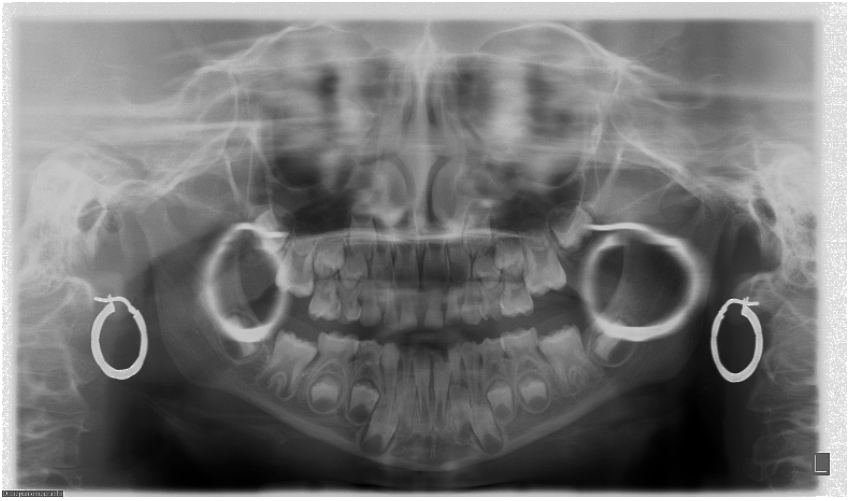
Figure 10. Artefacts by earrings. Note that the shape of each earring is mirror-like and is reflected on the contralateral mandibular ramus/third molar area in the form of an artefact.